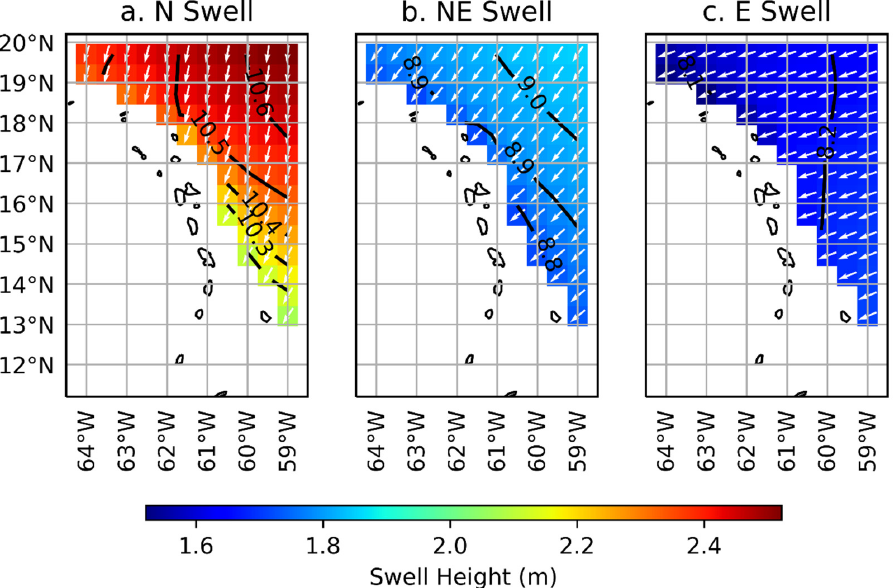
Figure 7. Composite averages of swell height (color), period (contours; units = seconds), and direction (arrows) for the ( a ) north, ( b ) northeast, and ( c ) east swell clusters. Days in the N swell cluster, which is the focus of the present study, are most frequent from December through March with the highest counts in December (243) and March (227) (Figure 8a). Swell direction during N swell days is most northerly in February (11.4°), March (14.5°), and January (16.4°) (Figure 8b). These are the same months with the lowest swell probabilities (Figure 8c). Swell heights are highest on average from December through February (2.4 m) and only slightly lower in March and November (2.3 m) (Figure 8d). Swell periods are smallest in November and January (10.4 s) and longest in December and March (10.5 s) (Figure 8e). Figure 8 differs from Figure 6 in that Figure 6 averages days based on the daily spatial average of swell direction only, while Figure 8 averages days based on membership in the N swell cluster, which accounts for swell direction, height, and period. North swell events with a probability <0.75 are listed in Table S1.